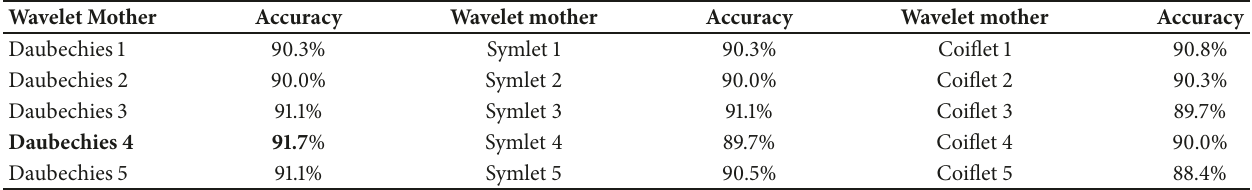
Table 4: The accuracy of driving style recognition using DWT-SVM with different wavelet mother functions.